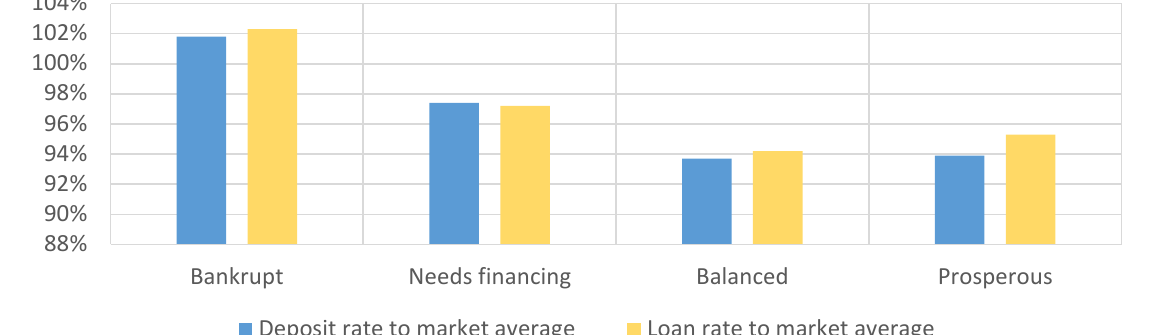
Figure 4. Interest rates over the respective market